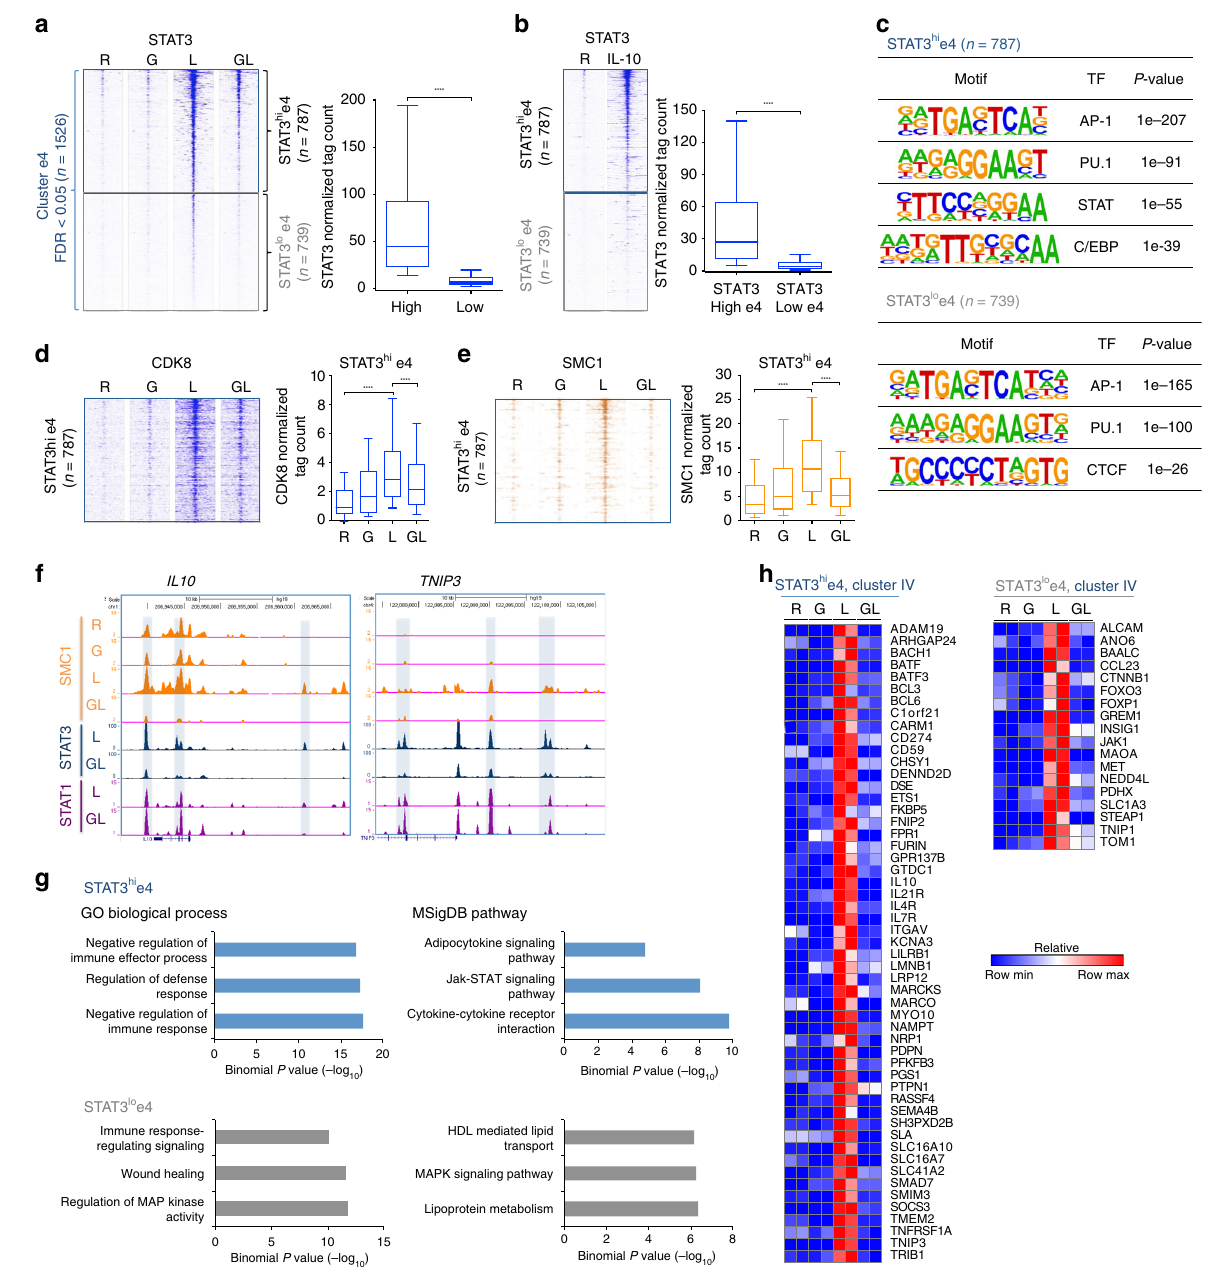
Fig. 6 The strength of STAT3 binding divides e4 enhancers into two subgroups. a Heatmaps of STAT3 ChIP-seq signals at cluster e4 enhancers in the four indicated conditions. Enhancers were separated into two subsets: STAT3 hi e4 ( n = 787) and STAT3 lo e4 ( n = 739) based upon a cutoff of log 2 normalized tag counts = 3). The boxplot (right) depicts normalized tag counts at STAT3 hi e4 and STAT3 lo e4 enhancers. b Heatmaps of STAT3 ChIP-seq signals at two subsets of e4 enhancers (de fi ned in a ) in resting and IL-10-stimulated macrophages. The boxplot (right) indicates normalized tag counts at STAT3 hi e4 and STAT3 lo e4 enhancers. c The most signi fi cantly enriched transcription factor (TF) motifs identi fi ed by de novo motif analysis using HOMER at STAT3 hi e4 (top) and STAT3 lo e4 (bottom) enhancers. d Heatmaps of CDK8 ChIP-seq signals at STAT3 hi e4 enhancers in the four indicated conditions. The boxplot (right) indicates normalized tag counts at STAT3 hi e4 enhancers. e Heatmaps of SMC1 ChIP-seq signals at STAT3 hi e4 enhancers in the four indicated conditions. The boxplot (right) indicates normalized tag counts at STAT3 hi e4 enhancers in four conditions. **** p < 0.0001, paired-samples Wilcoxon signed-rank test. f Representative UCSC Genome Browser tracks displaying normalized tag-density pro fi les at e4 enhancers of IL10 and TNIP3 in the indicated conditions. g Enriched Gene Ontology (GO) and MSigDB pathway categories of genes assigned to STAT3 hi e4 enhancers (upper panel) or STAT3 lo e4 enhancers (lower panel). h Heatmaps of IL-10-inducible cluster IV genes that correspond to STAT3 hi e4-associated genes (left panel) or non-IL- 10-inducible cluster IV genes that correspond to STAT3 lo e4-associated genes (right panel). Data are representative of two independent experiments each of which included at least two independent donors ( a , c , g , h ) or depict one ChIP experiment using pooled samples from independent experiments using two ( b ) or four different donors ( d , e ). Boxes encompass the twenty- fi fth to seventy- fi fth percentile changes. Whiskers extend to the tenth and ninetieth percentiles. The central horizontal bar indicates the